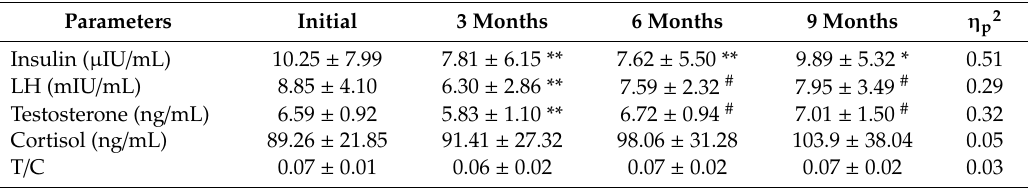
Table 4. Hormonal changes during the